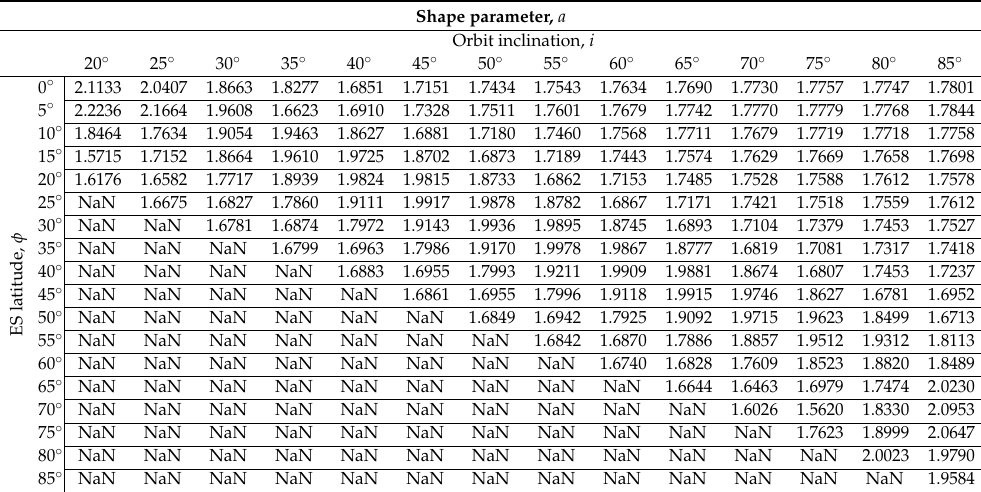
Table A6. Shape, a , and rate, b parameter for f Θ ( θ ) and F Θ ( θ ) for h k = 2000 km.